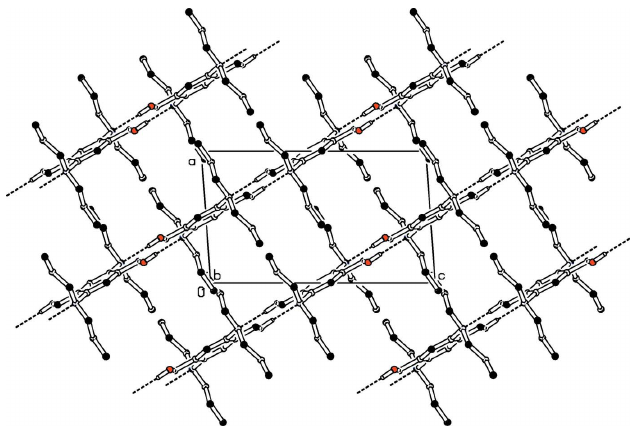
Figure 2 Partial packing diagram viewed along the b -axis direction. Hydrogen bonds are shown as dashed